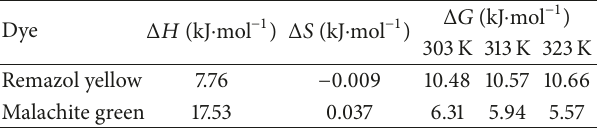
Table 2: Thermodynamic parameters for the adsorption of Remazol yellow and malachite green by carbonaceous